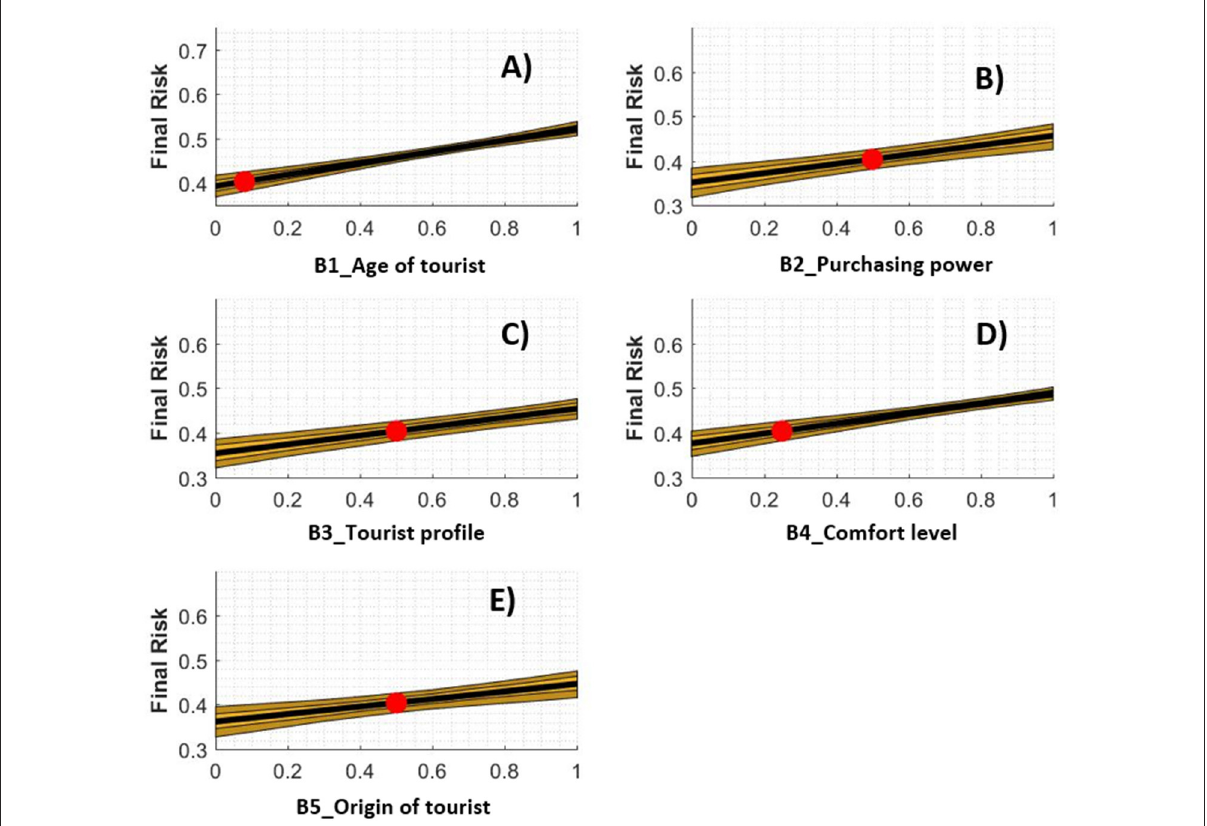
FIGURE10 Sensitivity of the risk of loss of tourism attractiveness due to heat stress (IC1) in the Balearic Islands to changes in single exposure indicators (black lines), represented in each subplot by (A) Age of tourist, (B) Purchasing power, (C) Tourist profile, (D) Comfort level, and (E) Origin of tourist. The red dot indicates the present value for each indicator and the orange patch represents the range of uncertainty. Note that the vertical axis is different in each subplot. Values normalized from 0 to